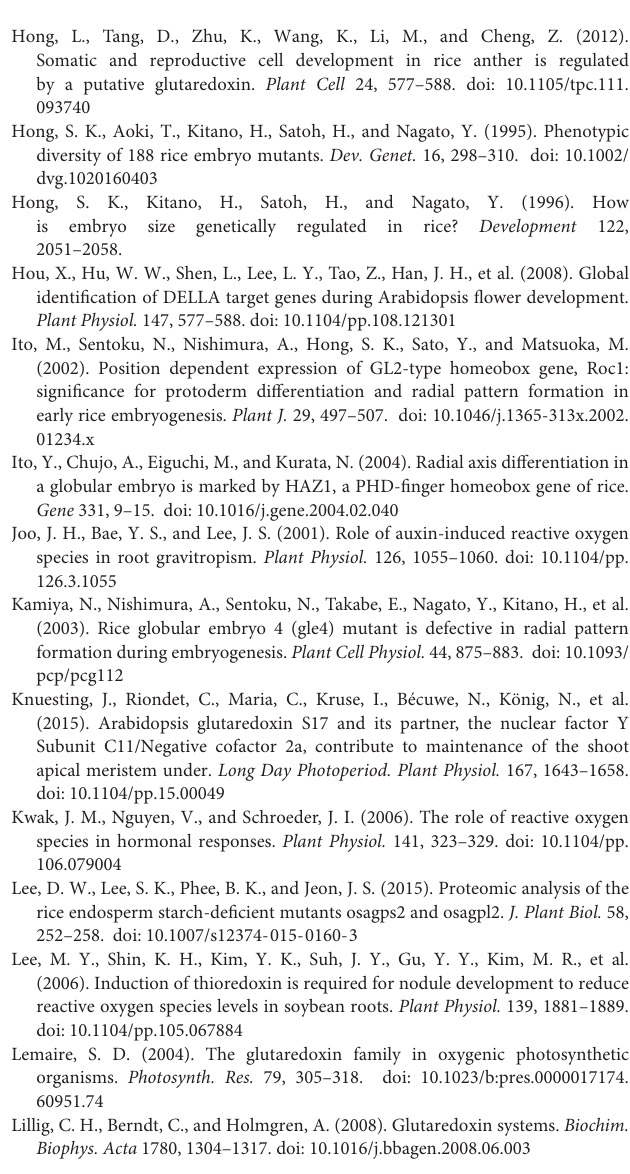
FIGURE S1 | Subcellular localization of the OsGrxC2.2 protein. FIGURE S2 | Median longitudinal sections of the WT and OsGrxC2.2 -over expression lines embryos at 3 DAP. Developing embryos of WT (A) and representative overexpression line OE11 (B) . FIGURE S3 | Phenotypic analysis of embryoless and WT seeds. (A) Hulled seeds. (B) Shelled embryoless and WT seeds. FIGURE S4 | Analysis of endosperm development maker genes in WT and OsGrxC2.2 -overexpression lines. Expression levels of genes involved in starch biosynthesis obtained via qRT-PCR analyses of AGPL1 , OsSSIIa , BE1 , and PUL from 10 DAP seeds of WT and OsGrxC2.2 -overexpression lines. The y -axis represents the gene expression relative to the OsActin1 transcript level. Results are the averages of three independent experiments. FIGURE S5 | Amino acid sequence alignment between OsGrxC2.2 and other class I Grx sequences in rice using ClustalW software. TABLE S1 | Primer sequences used in this